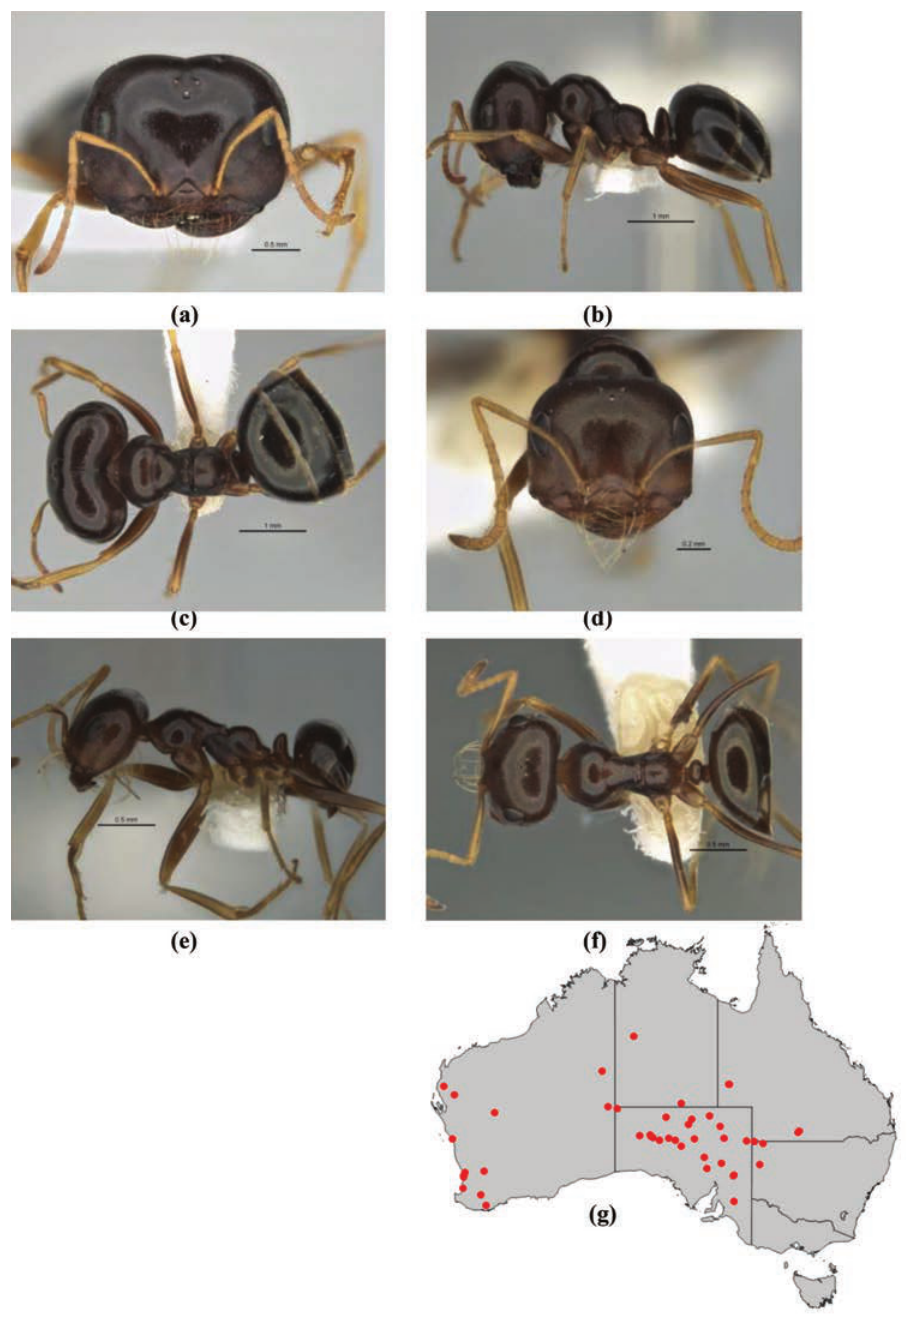
Figure 79. Melophorus chauliodon sp. n.: major worker paratype (ANIC32-900189–bottom ant) frons ( a ), profile ( b ) and dorsum ( c ); minor worker holotype (ANIC32-900189–middle ant) frons ( d ), profile ( e ) and dorsum ( f ); distribution map for the species ( g ). Low resolution scale bars: 1 mm ( b, c ); 0.5 mm ( a, e, f ); 0.2 ( d